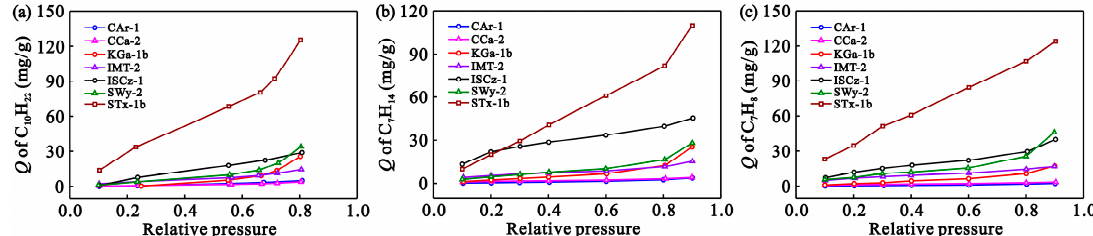
Figure 4. Tested amounts ( Q ) of C 10 H 22 ( a ), C 7 H 14 ( b ) and C 7 H 8 ( c ) with increasing P / P 0 for clay